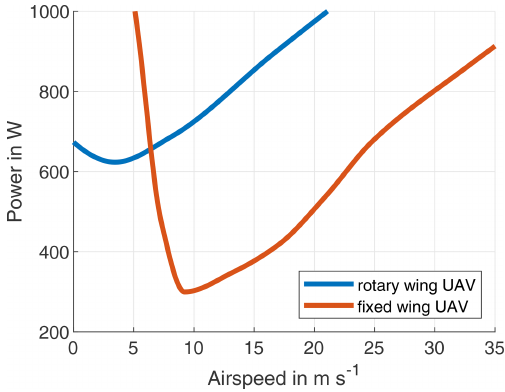
Figure 1. Power requirement of fixed-wing vs. rotary-wing UAVs with the same weight (redrawn from Poh and Poh,